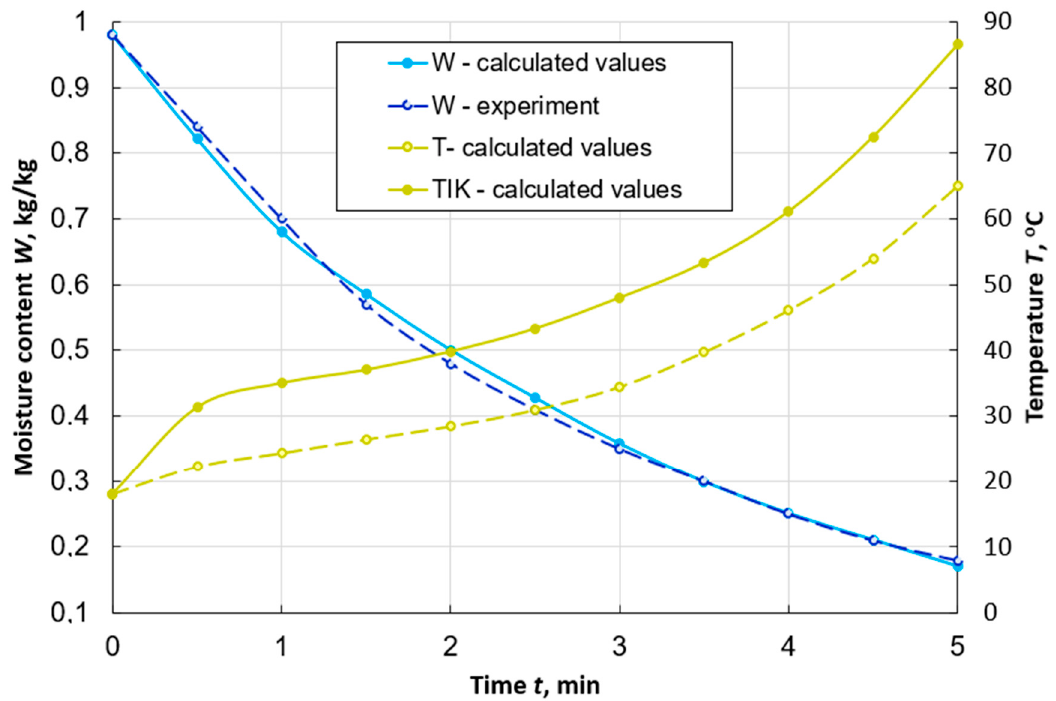
Figure 2. Graphs of changes in the average values of moisture content W and temperature T , as well as the temperature on the surface T IK of a spherical particle of peat with a diameter of d = 7 mm during its drying with the flow uniform washing with the following parameters: T e.m. = 120 ◦ C, w e.m. = 1 m/s, d e.m. = 10 g/kg of dry air.